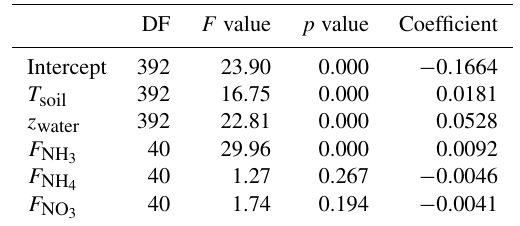
Table 1. Results of fitting the linear mixed-effects model (Eq. 2) to the data by maximising the restricted log-likelihood. Columns show the denominator degrees of freedom, F values, p values from Wald tests for each term, and the β coefficients in Eq. (2).